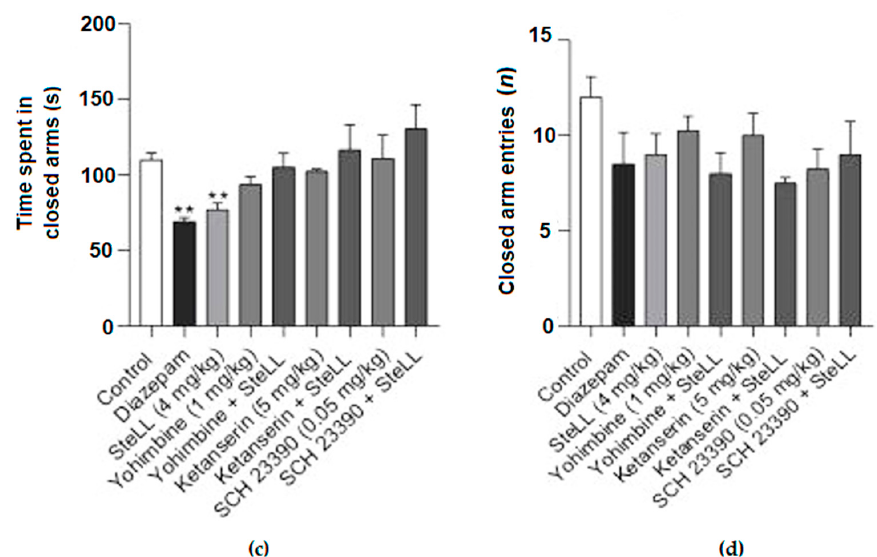
Figure 5. The anxiolytic-like effect of SteLL in the EPM was dependent on monoaminergic signaling. The pretreatment with the nonselective antagonist of the α 2-adrenoceptor yohimbine 1 mg/kg, the 5-HT2A/2C serotonin receptor antagonist ketanserin 5 mg/kg, and the D1 dopamine receptor antagonist SCH 23390 0.05 mg/kg inhibited the effect of SteLL (4 mg/kg) on the time spent in the open ( a ) and closed ( c ) arms. No changes were observed in the number of entries in open ( b ) and closed ( d ) arms. The antagonists were administrated 15 min before SteLL administration. The experiments were conducted 15 min after SteLL administration. (**) p < 0.001; (***) p < 0.0001 compared to control.